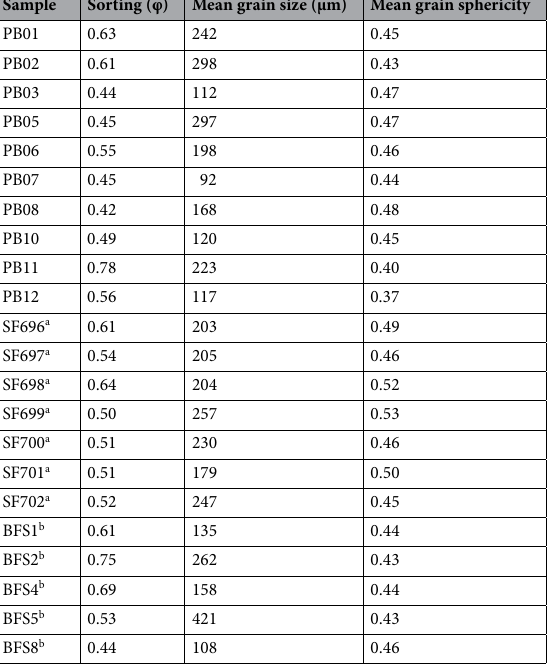
Table 1. Grain-based measurements made for each sample. a Payton et al. 17 . b Thomson et al. 18